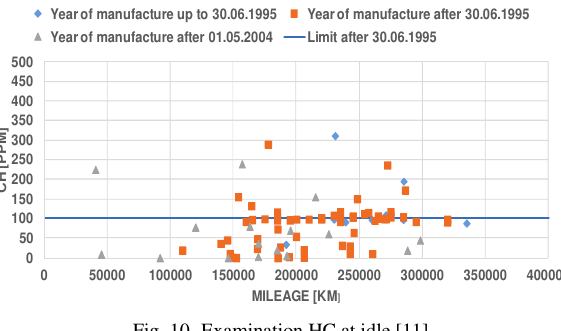
Fig. 10. Examination HC at idle [11]